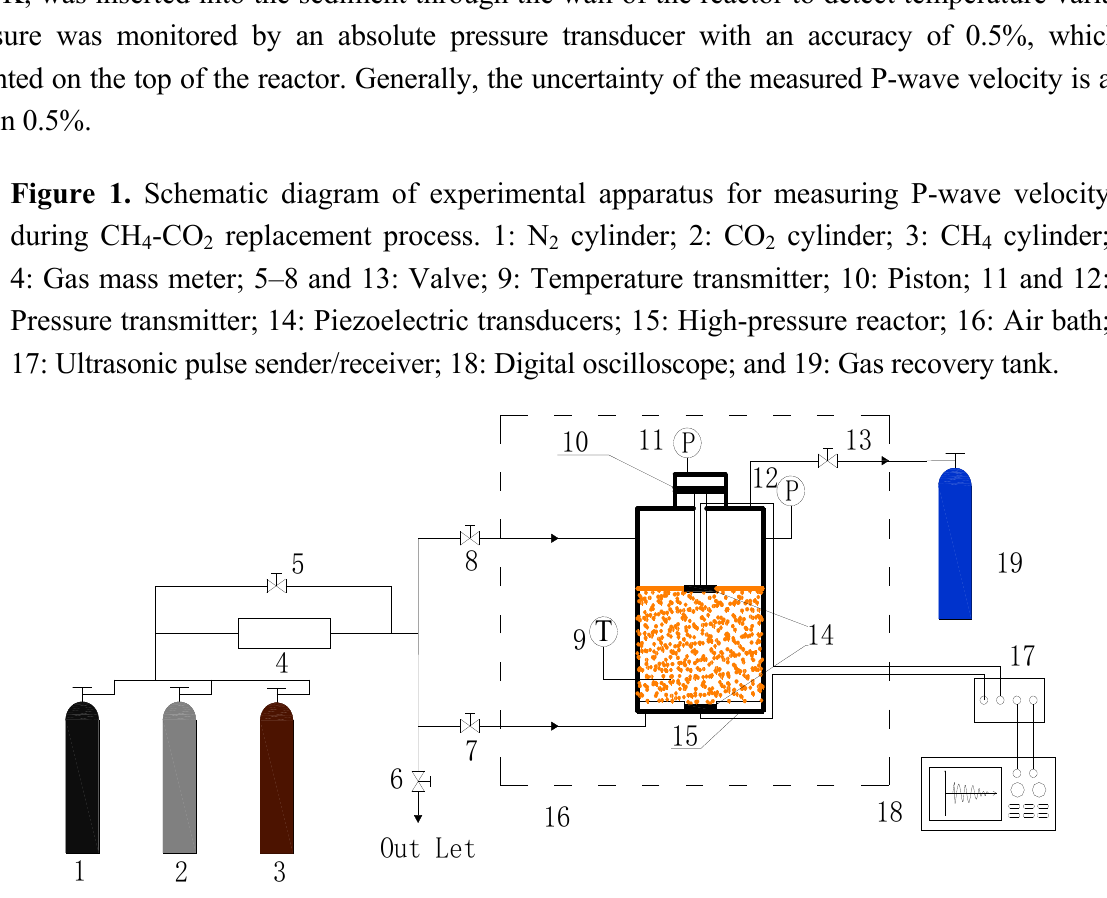
cylinder; 2: CO cylinder; 3: CH cylinder; 2 2 4